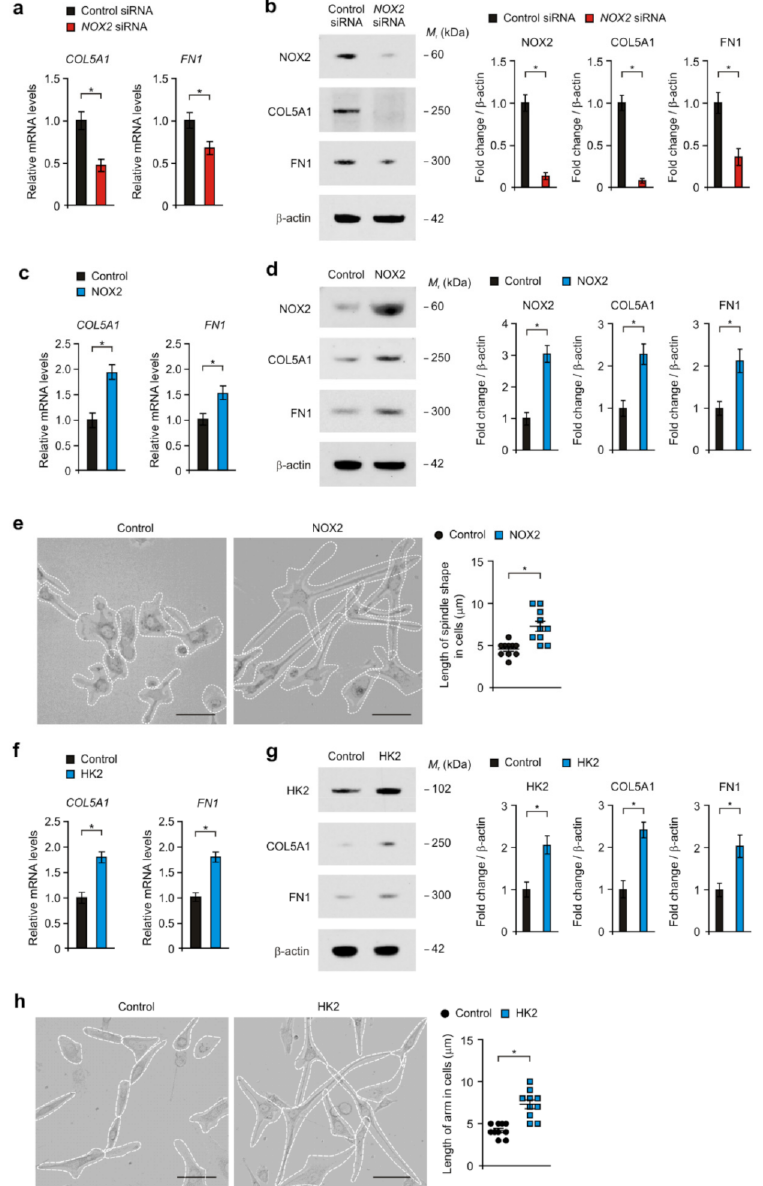
Figure 5. NOX2 and HK2 induce COL5A1-mediated mesenchymal phenotype in human glioma cells. ( a ) The levels of COL5A1 and FN1 mRNA and ( b ) representative immunoblot images (left) and quantification (right) of COL5A1 and FN1 protein levels in human glioma cells treated with NOX2 siRNA or control siRNA. β -actin was used as a loading control. ( c ) The levels of COL5A1 and FN1 mRNA and ( d ) representative immunoblot images (left) and quantification (right) of COL5A1 and FN1 protein levels in human glioma cells with NOX2 over-expression (NOX2) or control (Control). β -actin was used as a loading control. ( e ) Representative images of cellular morphology in U87MG glioma cells with NOX2 over-expression (HK2) or control (Control) (left). Quantification of spindle shape length in U87MG glioma cells with NOX2 over-expression or control (right). Scale bars, 20 µ m. ( f ) The levels of COL5A1 and FN1 mRNA and ( g ) representative immunoblot images (left) and quantification (right) of COL5A1 and FN1 protein levels in U87MG glioma cells with HK2 over-expression (HK2) or control (Control). ( h ) Representative images of cellular morphology in U87MG glioma cells with HK2 over-expression (HK2) or control (Control) (left). Scale bars, 20 µ m. Quantification of spindle shape length in human glioma cells with HK2 over-expression (HK2) or control (Control) (right). The results are representative of three independent experiments and are shown as the mean ± SEM. * p < 0.05; Student’s two-tailed t